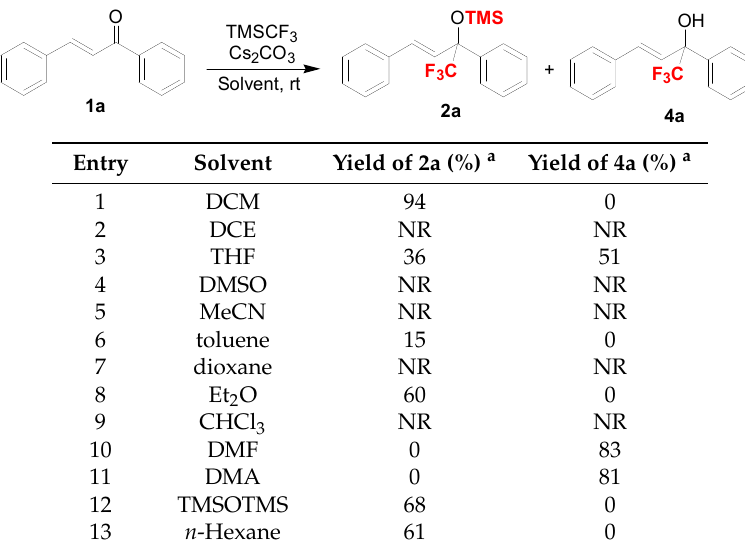
Table 2. The solvent effect on the Cs 2 CO 3 -catalyzed trifluoromethylation of chalcone 1a with TMSCF 3 .